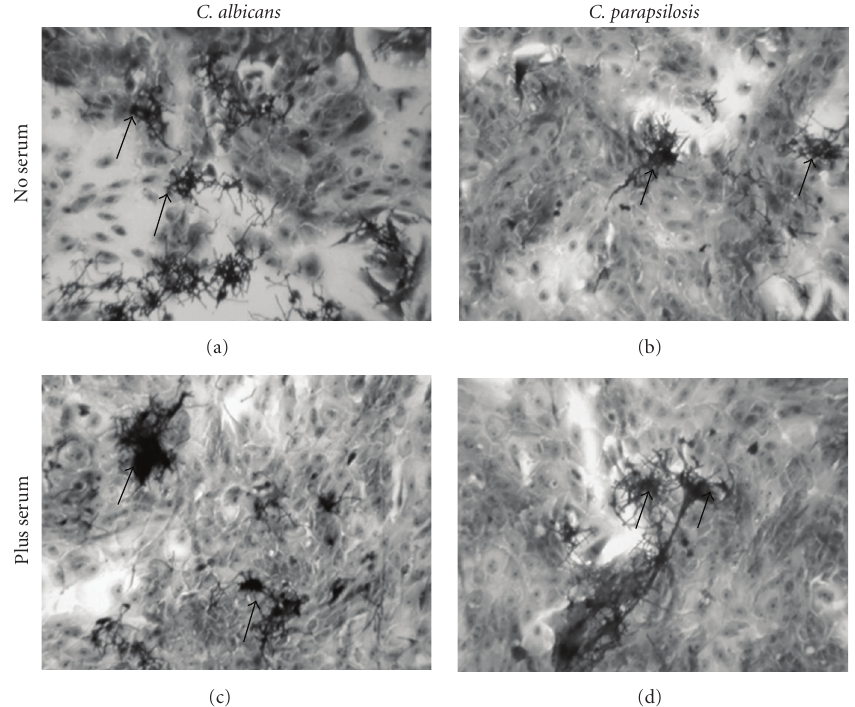
Figure 3: C. parapsilosis adhesion to the gingival epithelial monolayer culture. Human gingival cells were grown up to 80% confluence, pulsed with C. parapsilosis or C. albicans , and incubated for 6 hours with or without serum. Following this culture period, the supernatant containing nonattached Candida was discarded, and the cultures were washed and stained with Cristal violet. Representative photographs are presented. Magnification: 250 × .